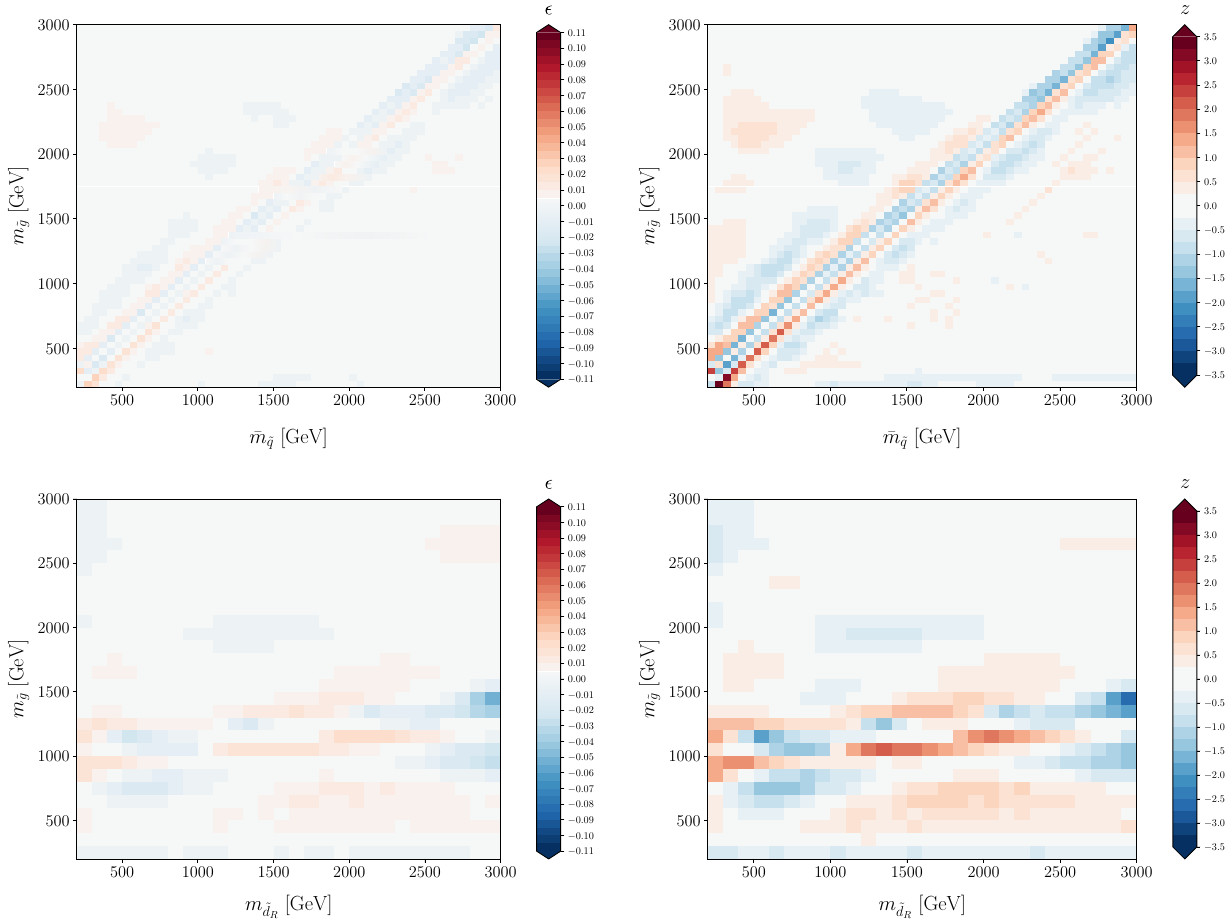
Fig. 8 The relative error (left) and residual (right) for the gluino pair-production cross-section as a function of the gluino mass versus a common squark mass (top) and the ˜ d R mass (bottom). All other masses are fixed at